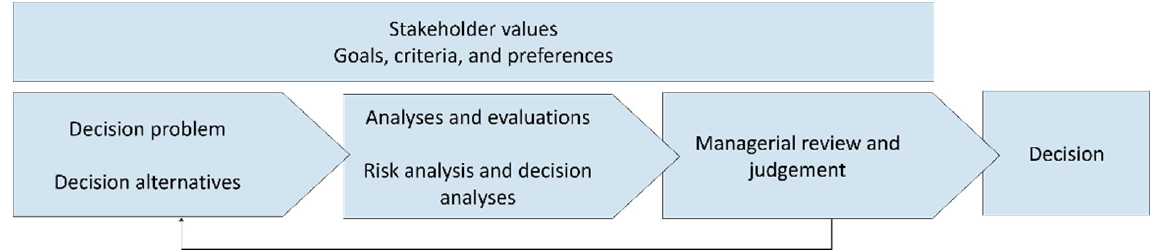
Figure 1. Risk chain of I/I illustrating the relationship of components defining risk in the framework.